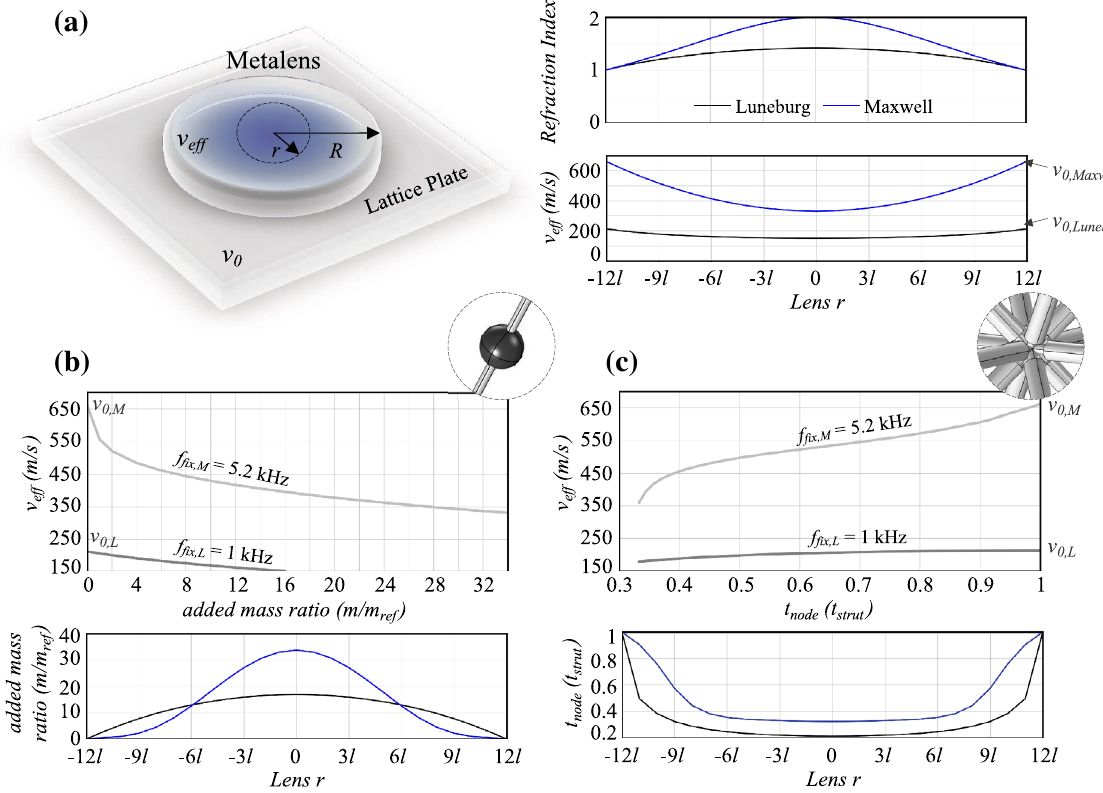
Figure 6. GRIN lenses design. ( a ) Schematic of the metalenses setup with geometry ( R =0.72m) and phase velocities in the lattice plate, v 0 , and metadevice, v eff , respectively emphasized. The right inset illustrates the index and effective velocity profiles of Luneburg (black) and Maxwell (blue) lenses as a function of the radial coordinate, r . v 0, Luneburg and v 0, Maxwell are the reference velocities of waves in the base lattice plate at 1 kHz and 5.2 kHz. At r = R , v eff = v 0 . ( b ) and ( c ) Design parameters of GRIN lenses comprising the customized octets with auxiliary masses or variable node thickness (see Fig. 1c and d). The top inset represents the variation of effective phase velocity with respect to the tuning parameter at the fixed design frequencies of Luneburg and Maxwell lenses. The derived parameters are reported in the bottom